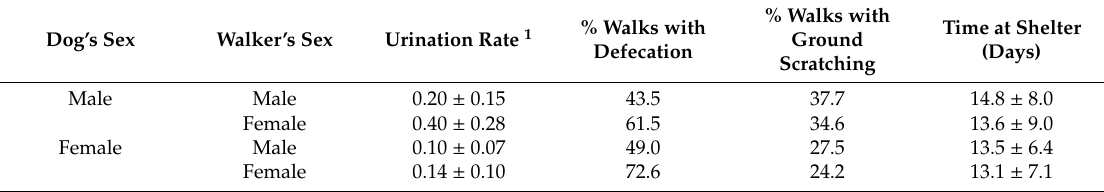
Table 1. Descriptive statistics (Mean ± SD ) for rate of urination by male and female dogs during a 20-min walk by either male or female walkers, along with time at shelter. Additionally, percentage of walks in which dogs defecated or ground scratched are